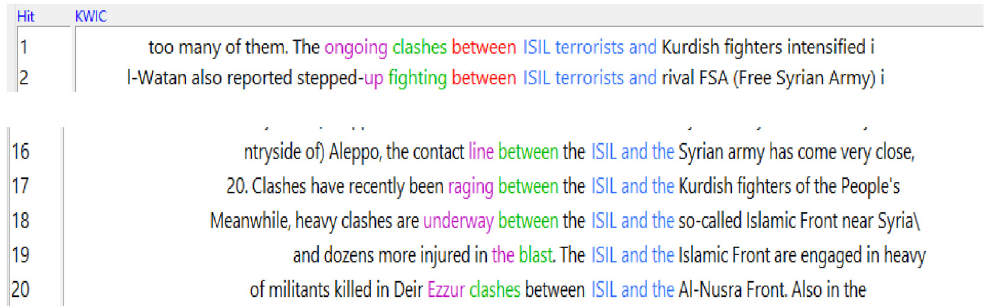
Figure 8: Concordances of ISIL terrorists and; ISIL and the .